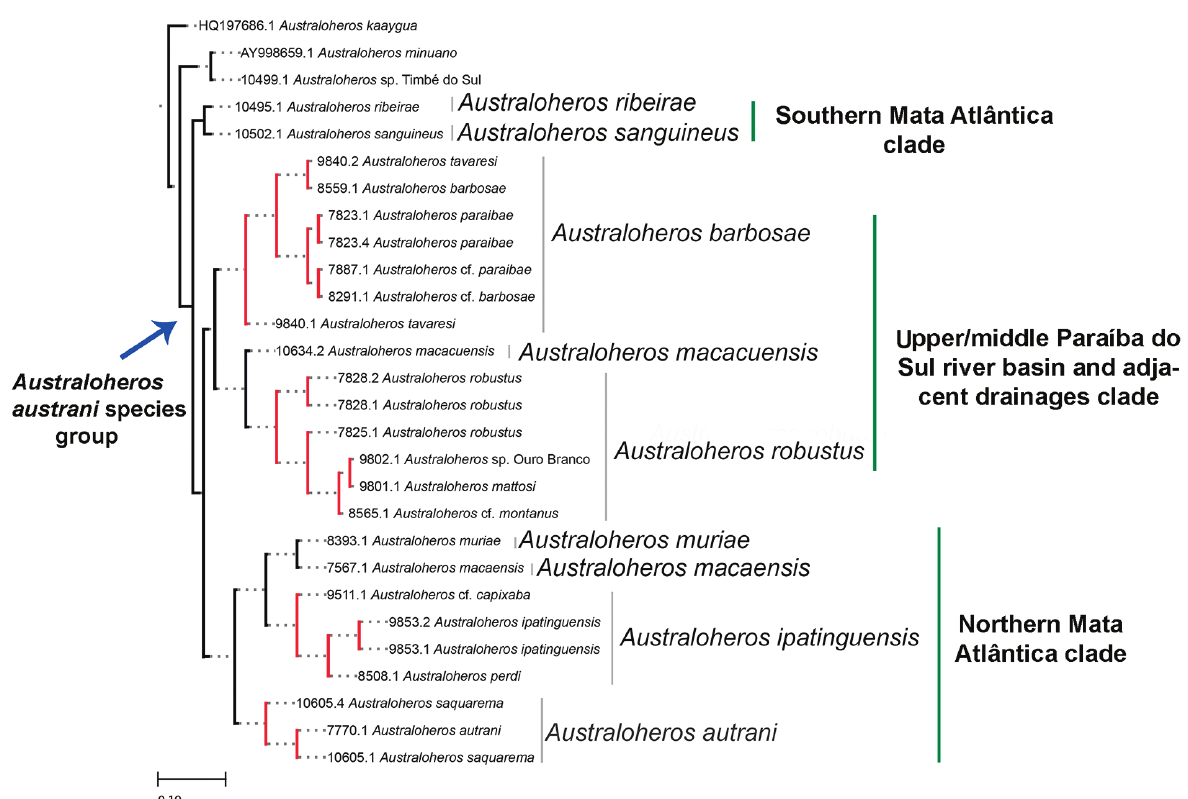
Figure 3. Species delimitation tree generated by the Bayesian Poisson Tree Pro cesses (bPTP) model, using a fragment of the mi- tochondrial gene CYTB. Black lines indicate branching processes among species, red lines indicate branching processes within species. Species of the A. autrani species group delimited through bPTP are indicated with grey